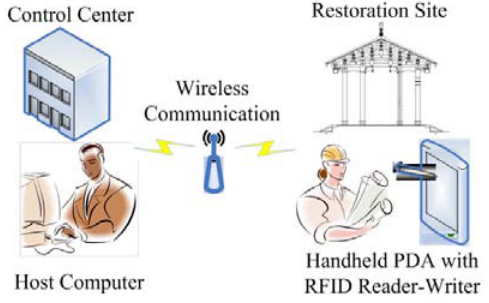
Fig. 2. Data transmission used in the historic timber